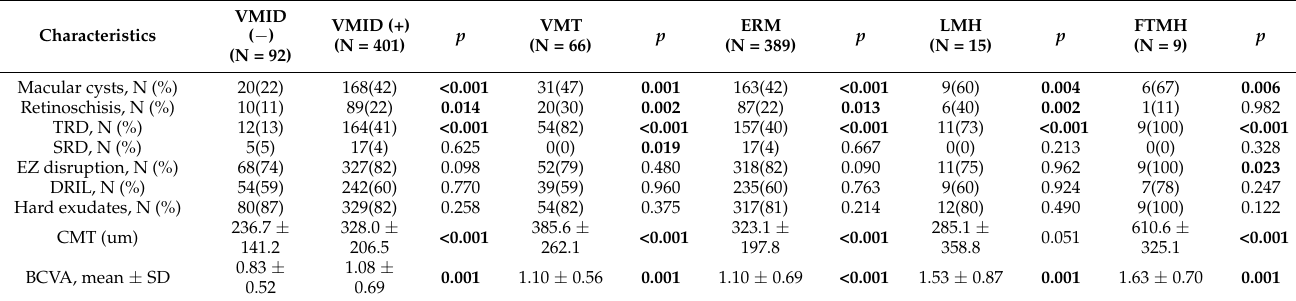
Table 4. Intraretinal structure and visual acuity in proliferative diabetic